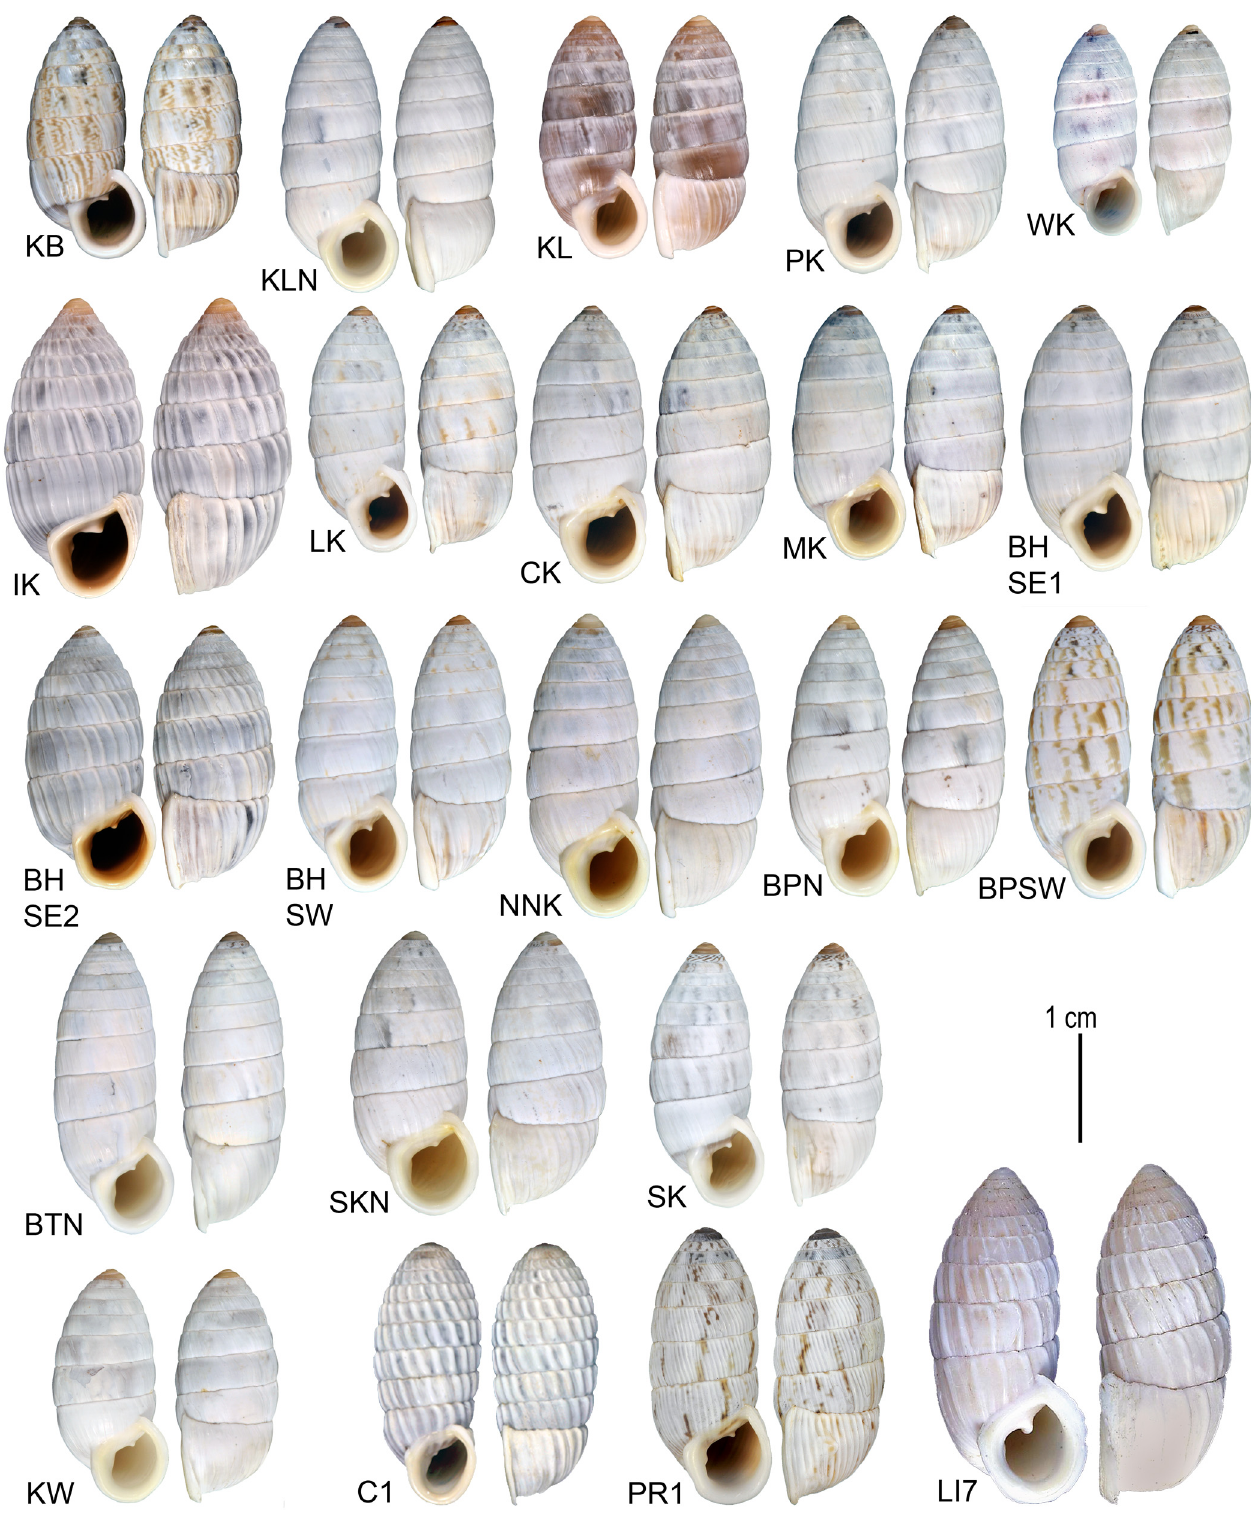
Fig 2. Representative specimens of Cerion populations used in this study. Labels correspond to station letter designations in Table 1.